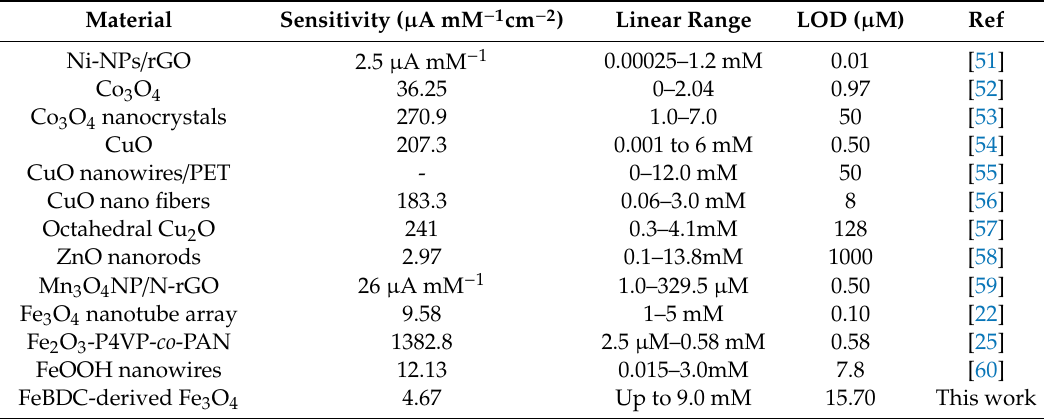
Table 2. Various non-enzymatic glucose biosensors based on iron